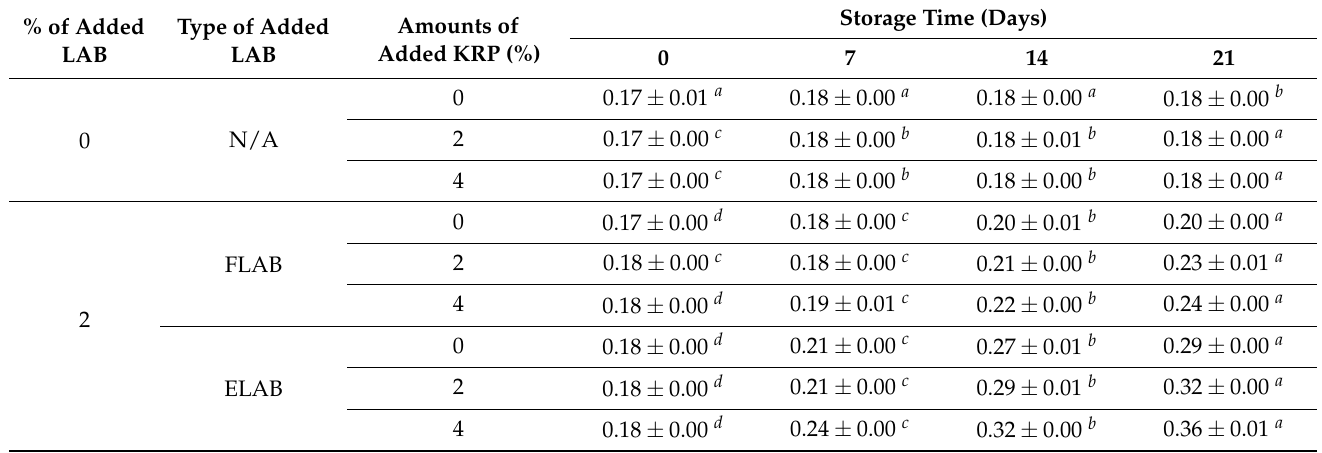
Table 1. The impact of storage time on the titratable acidity (% lactic acid content) of chocolate milk enriched with 0% or 2% (FLAB or ELAB) and different concentrations (0%, 2% and 4%) of KRP. Data are presented as mean ± standard deviation. Means in a row followed with different superscript letters are significantly different (95% confidence level).